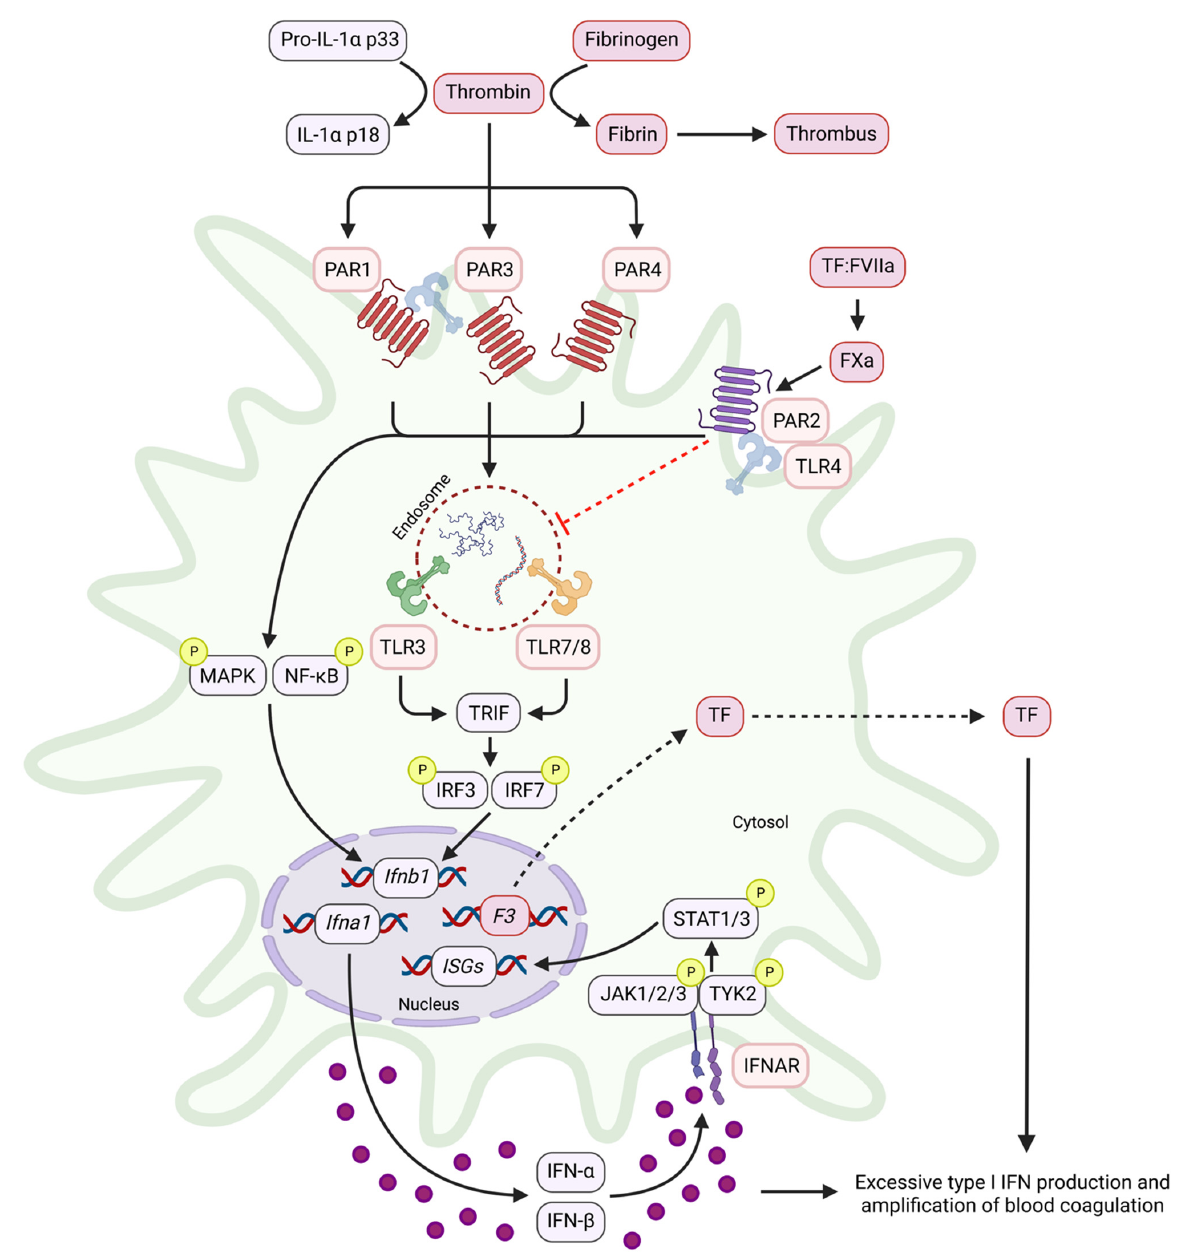
Figure 2. Induction of type I IFNs and downstream blood coagulation by PARs. In addition to thrombin’s procoagulant (cleavage of fibrinogen) and proinflammatory (cleavage of IL-1 α )